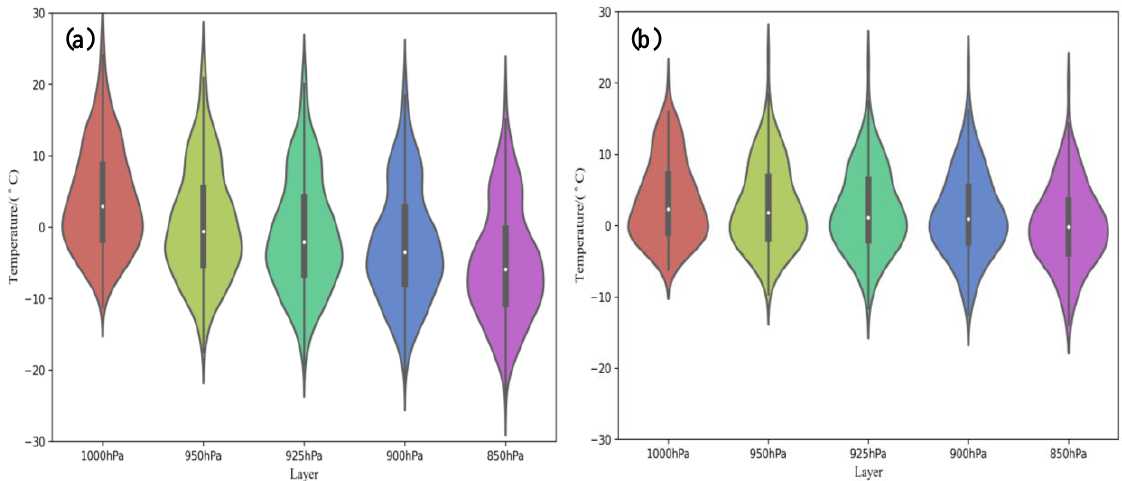
Figure 3. Observations of the temperature during the clean days ( a ) and polluted days ( b ). The correlations of the temperature between the observations and the NCEP/FNL data in different layers during clean days and polluted days are shown in Figure 4 and Table 3. The NCEP/FNL data are slightly lower than the observations, with the BIAS ranging from − 0.15 to − 0.75 ◦ C on the clean days and from − 0.45 to − 0.81 ◦ C on the polluted days. The test metrics show that the NCEP/FNL reanalysis data perform better in the middle and lower layers (850–950 hPa) than in the near-surface layer (1000 hPa) on both the clean days and polluted days. Taking the CC as an example, the CC s range from 0.94 to 0.95 on clean days and from 0.92 to 0.93 on polluted days in the middle and lower layers, while they decrease to 0.90 and 0.84 in the near-surface layer on clean days and polluted days, respectively. The bad performance of the NCEP/FNL at 1000 hPa may be attributed to the topography and land-use types adopted in the reanalysis model, as well as other factors. Overall, the NCEP/FNL data have the highest CC for temperature, and they generally show no significant difference between clean days and polluted days. As a result, the prediction reliability of the temperature is the best compared with those of the relative humidity and wind speed (discussed in Sections 3.1.2 and